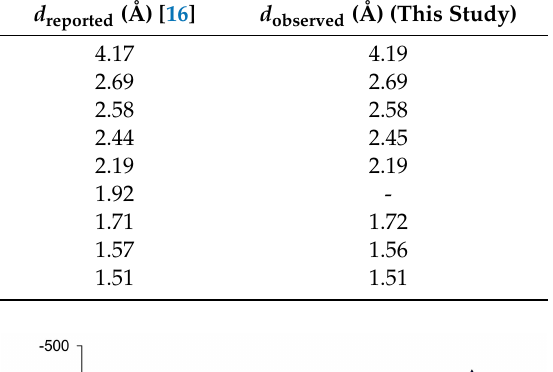
Table 1. Comparison of d-spacing of the synthesized goethite in this study with other reference [16]. d reported (Å) [16]